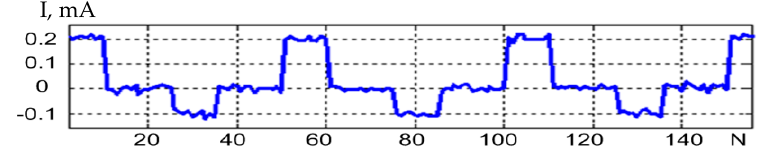
Figure 14. Noise suppression via averaging of corresponding pulses.